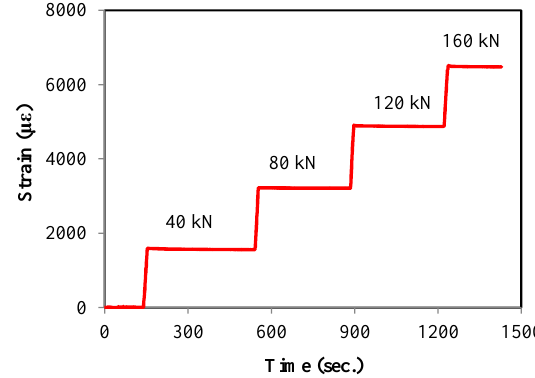
Figure 8. Strain measured by FBG sensor.